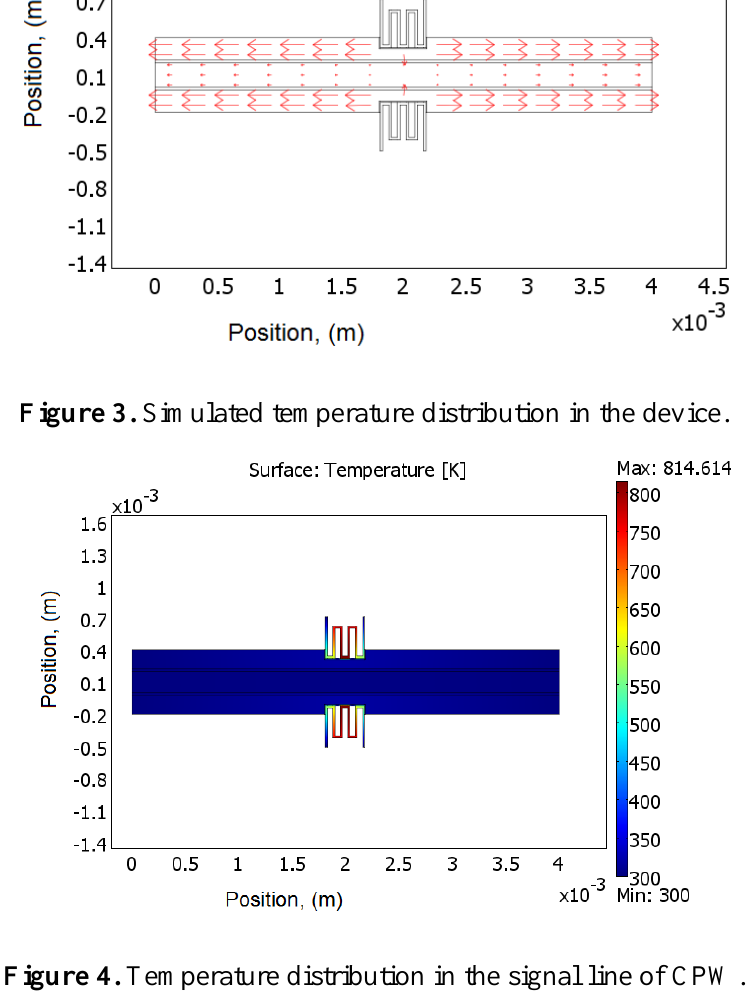
Figure 4. Temperature distribution in the signal line of